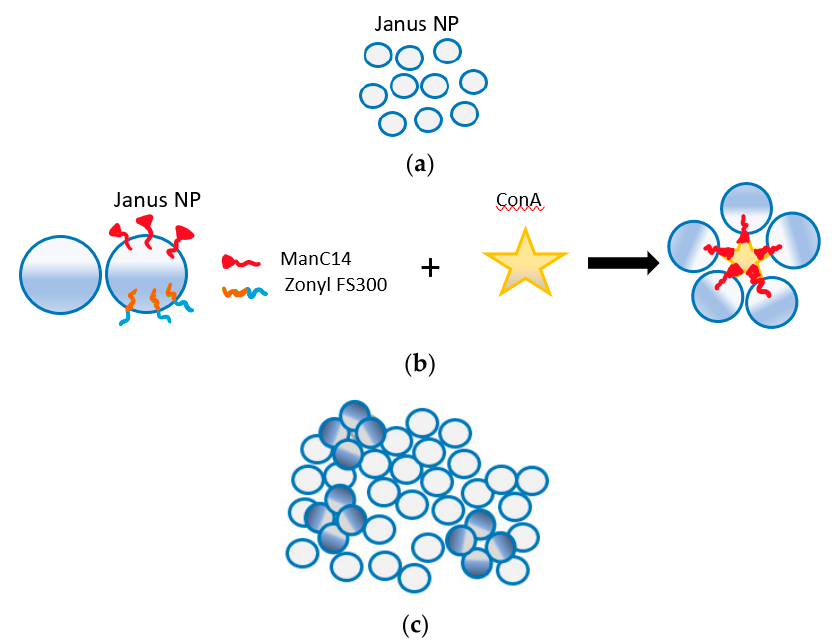
Figure 11. ( a ) Optical top view for Janus droplets shows their transparency. ( b ) Part of Janus partials forming carbohydrate-based interactions is capable of binding to ConA which is like antigens of E. Coli . ( c ) Binding with ConA shows how Janus droplets cluster causing optical changes.